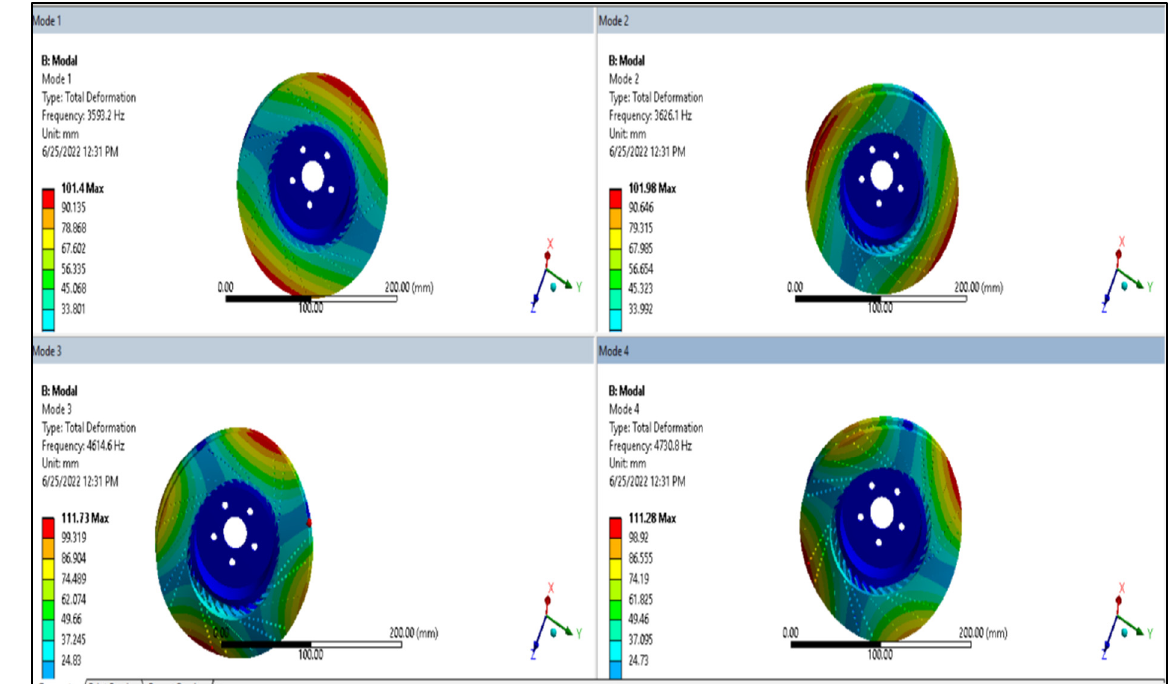
Figure 7. Mode shape result of AMNC disc.